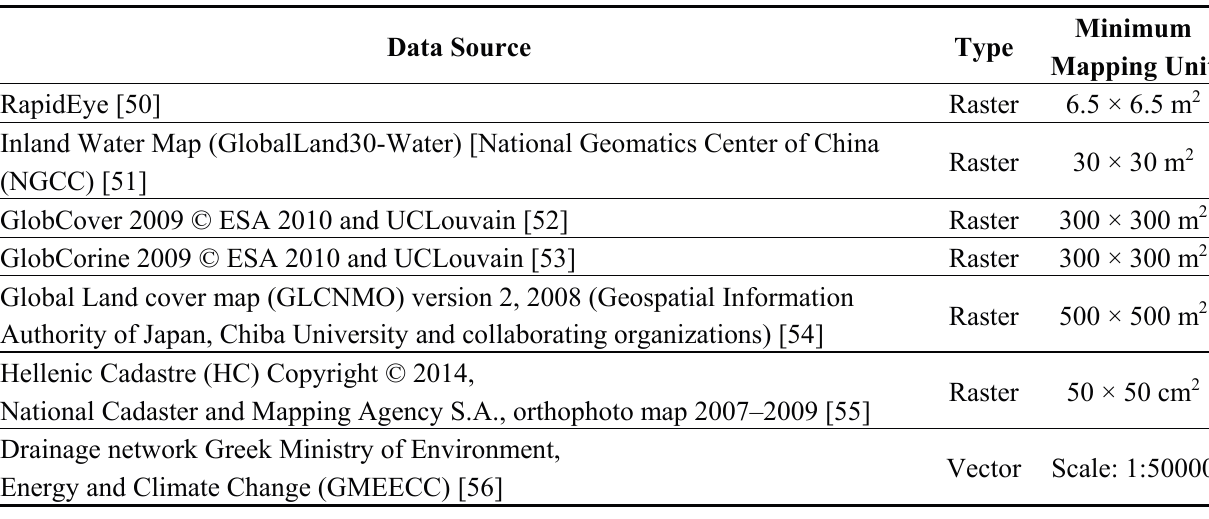
Table 1. Data sources and data types used in the present